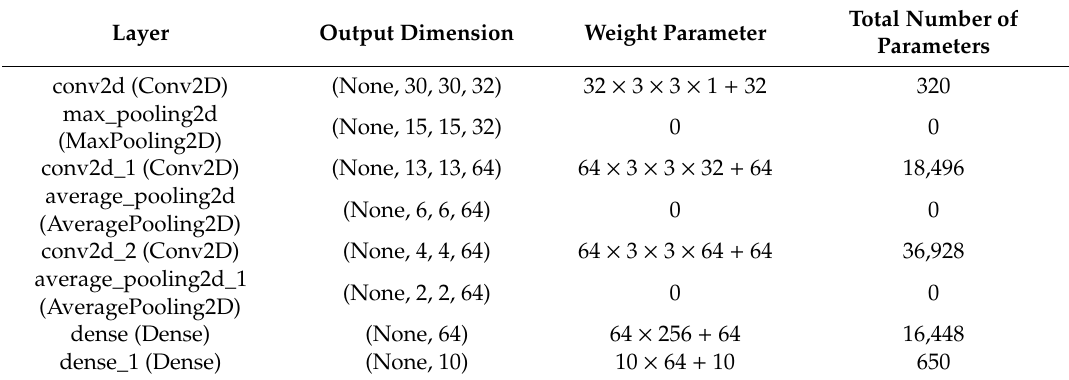
Table 1. Parameters of di ff erent